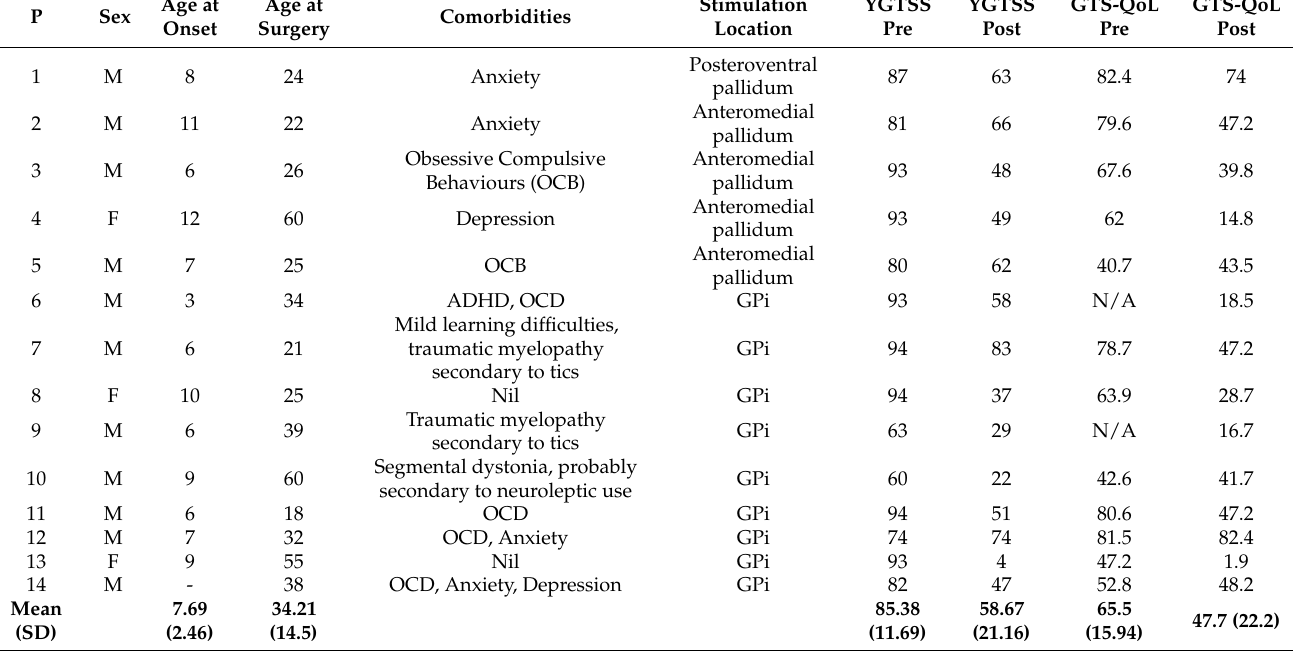
Table 1. Demographic and clinical characteristics of the patients with Tourette